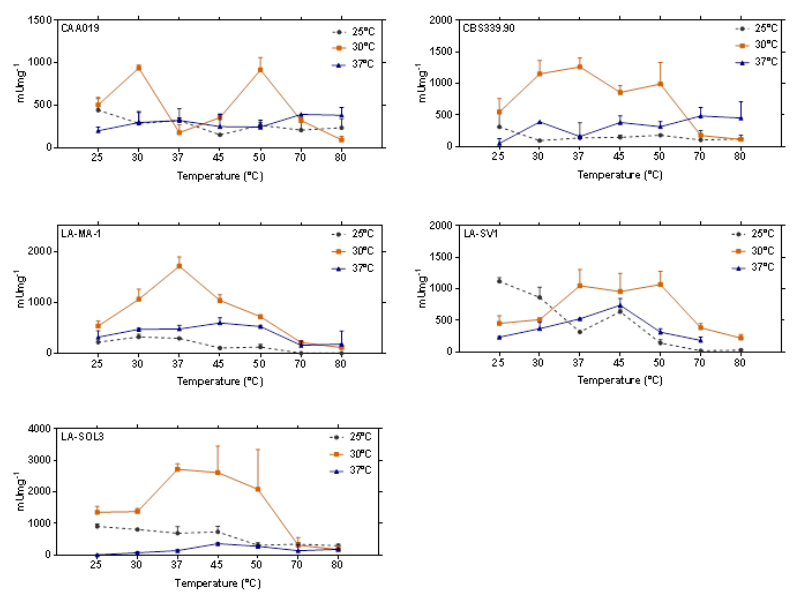
Figure 6. Extracellular proteolytic activity of strains CAA019, CBS339.90, LA-MA-1, LA-SV1 and LA-SOL3 grown at 25 °C, 30 °C and 37 °C and tested at 7 different temperatures. Data is presented as average ± standard deviation.